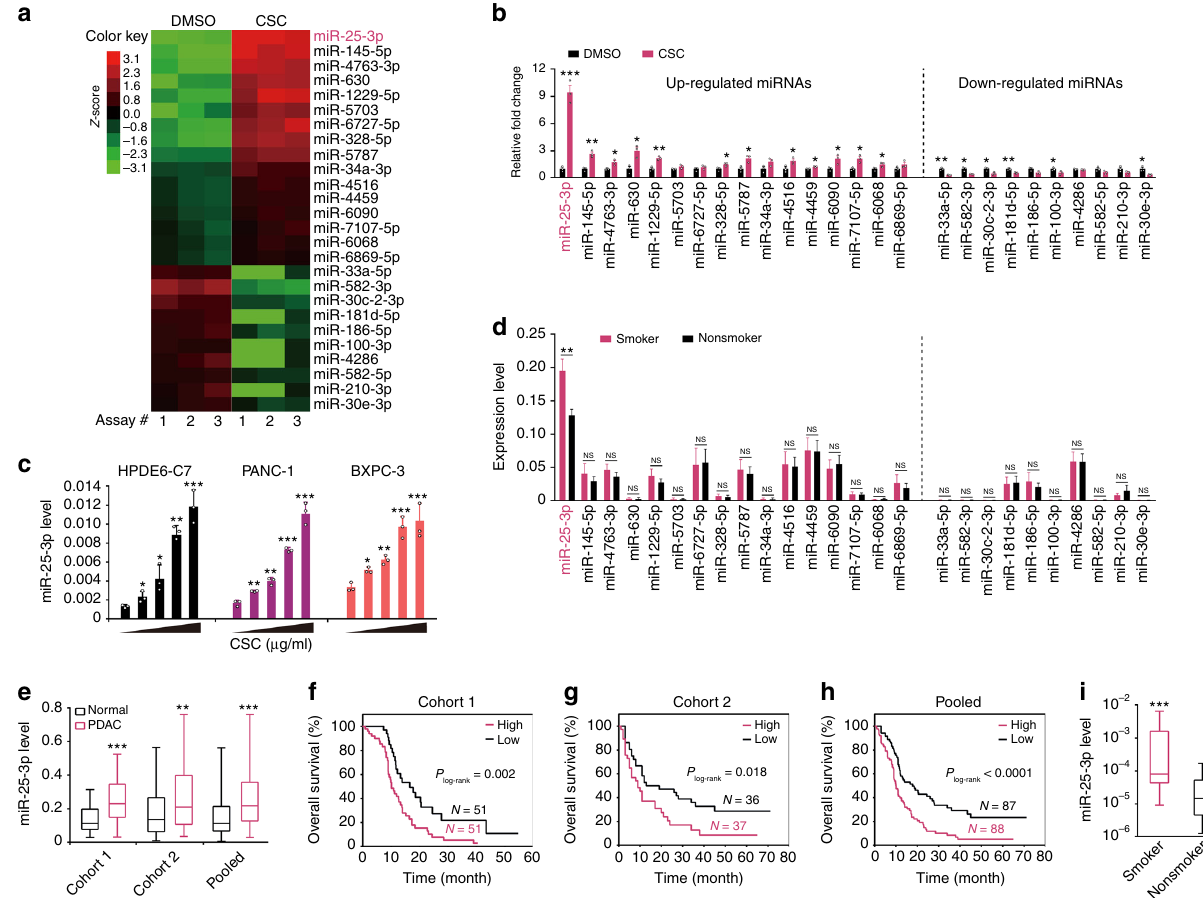
Fig. 1 MiR-25-3p induction by CSC and its effect on survival time of individuals with PDAC. a Heatmap of signi fi cantly different expression of microRNAs ( P < 0.05, fold change > 2 or < 0.5) detected with microRNA array in HPDE6-C7 cells exposed to CSC (100 µ g/ml) or equal amount of DMSO as solvent control. The red (higher expression) or green (lower expression) color represents the normalized expression value of indicated microRNAs. b Expression levels of indicated miRNAs in HPDE6-C7 cell exposed to CSC (100 μ g/ml) or equal amount of DMSO as vehicle control. Results represent means ± standard derivation (S.D.) from three independent measurements. c The induction of miR-25-3p overexpression in HPDE6-C7, PANC-1, and BXPC-3 cells was in a CSC dose (0, 0.1, 1.0, 10, and 100 µ g/ml) dependent manner. Data represent mean ± S.D. from three independent experiments. d Expression levels of indicated miRNAs in non-tumor tissue samples of smokers ( N = 67) or nonsmokers ( N = 108). Results represent means ± S.D. from three independent measurements. e Aberrant overexpression of miR-25-3p in surgically removed PDAC samples compared with their paired non-tumor tissue samples in two patient groups and combined sample. f – h Kaplan – Meier estimates of survival time in two groups of patients with PDAC and combined sample by different miR-25-3p levels in tumor. The median survival time for individuals with high miR-25-3p levels ( ≥ median) in Guangzhou, Beijing and combined sample was 10.1, 9.0, and 10.1 months compared with 16.6, 16.0, and 17.8 months in those with low miR-25-3p levels (<median), with the hazard ratio and 95% con fi dence interval (CI) of 2.20 (95% CI, 1.53 – 3.63), 1.82 (95% CI, 1.15 – 3.36), and 2.07 (95% CI, 1.50 – 3.09). i Signi fi cant difference in serum miR-25-3p levels among smokers ( N = 22) and nonsmoker ( N = 23). Data of ( e ) and ( i ) are displayed in min to max boxplot. The line in the middle of the box is plotted at the median while the upper and lower hinges indicated 25th and 75th percentiles. Student t tests were used in ( a ), ( b ), and ( c ) (NS, non-signi fi cant, * P < 0.05, ** P < 0.01, and *** P < 0.001) and Wilcoxon rank-sum tests were used in ( d ), ( e ), and ( i ) (NS, non-signi fi cant, ** P < 0.01, and *** P < Fig. 5b). Knocking down of NFIC expression in HPDE6-C7 and PDAC cells resulted in substantially decreased METTL3 levels (Fig. 2i) and the transcriptional activity of METTL3 promoter (Supplementary Fig. 5c). CSC exposure signi fi cantly increased NFIC enrichment within the METTL3 regulatory region (Fig. 2j) and the transcriptional activity of METTL3 promoter (Supple- mentary Fig. 5d), while the NFIC expression level was not changed (Supplementary Fig. 5e). Similar to the effect of METTL3 depression, NFIC knockdown also substantially inhibited CSC- induced miR-25-3p overexpression in HPDE6-C7 and pancreatic cancer cells (Supplementary Fig. 5f). Remarkably, we detected a signi fi cantly more enrichment of NFIC within METTL3 reg- ulatory region in non-tumor pancreatic tissues from smokers